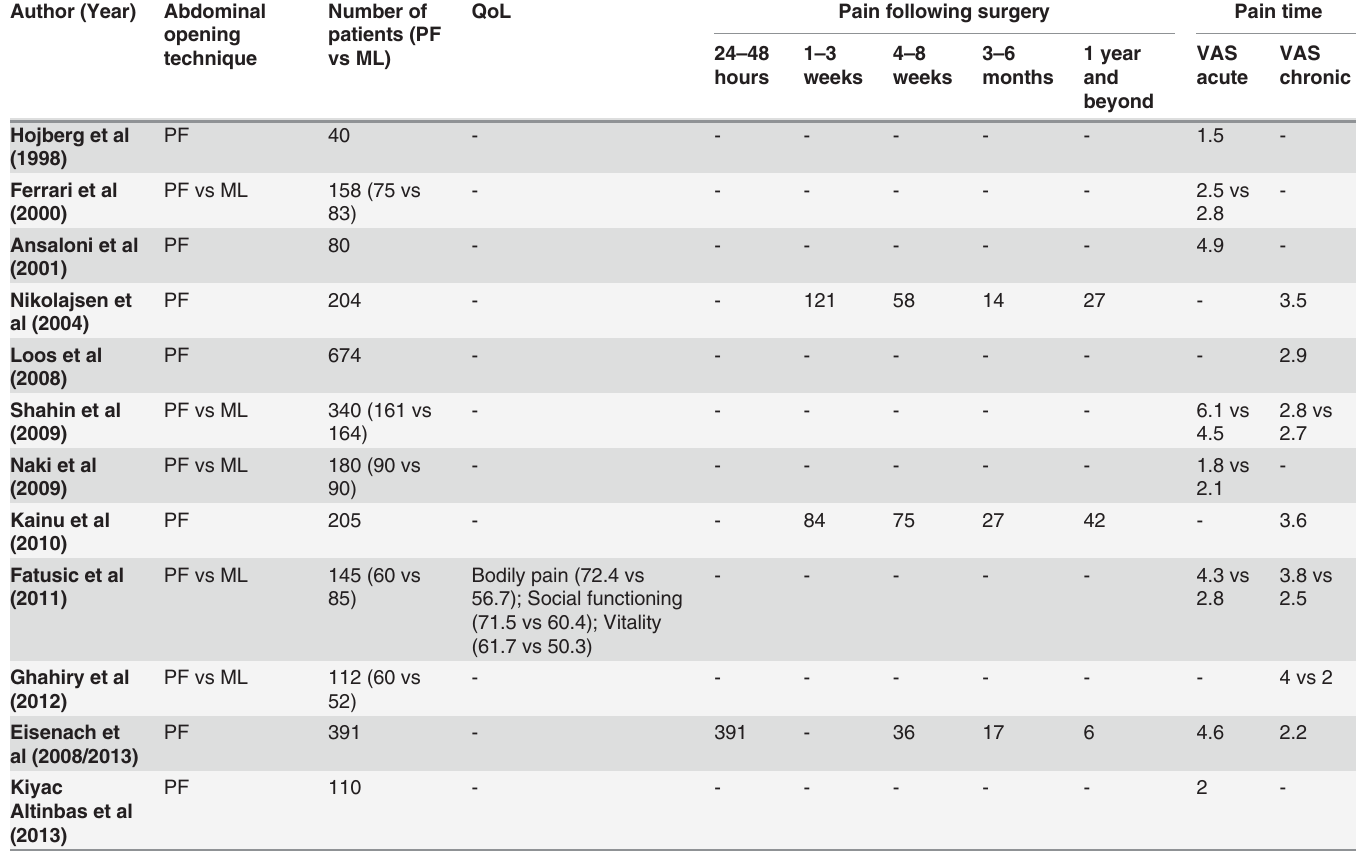
Table 2. Data about quality of life and acute/chronic pain of eligible population. Author